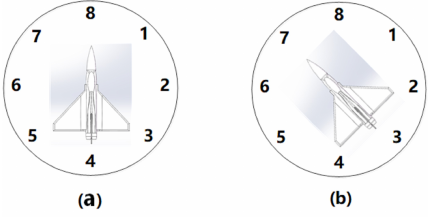
Figure 6. 8 Basic directions: ( a ) Schematic diagram of the eight directional positions of the UAV in initial formation; ( b ) Schematic diagram of the eight directional positions of the UAV after turning.